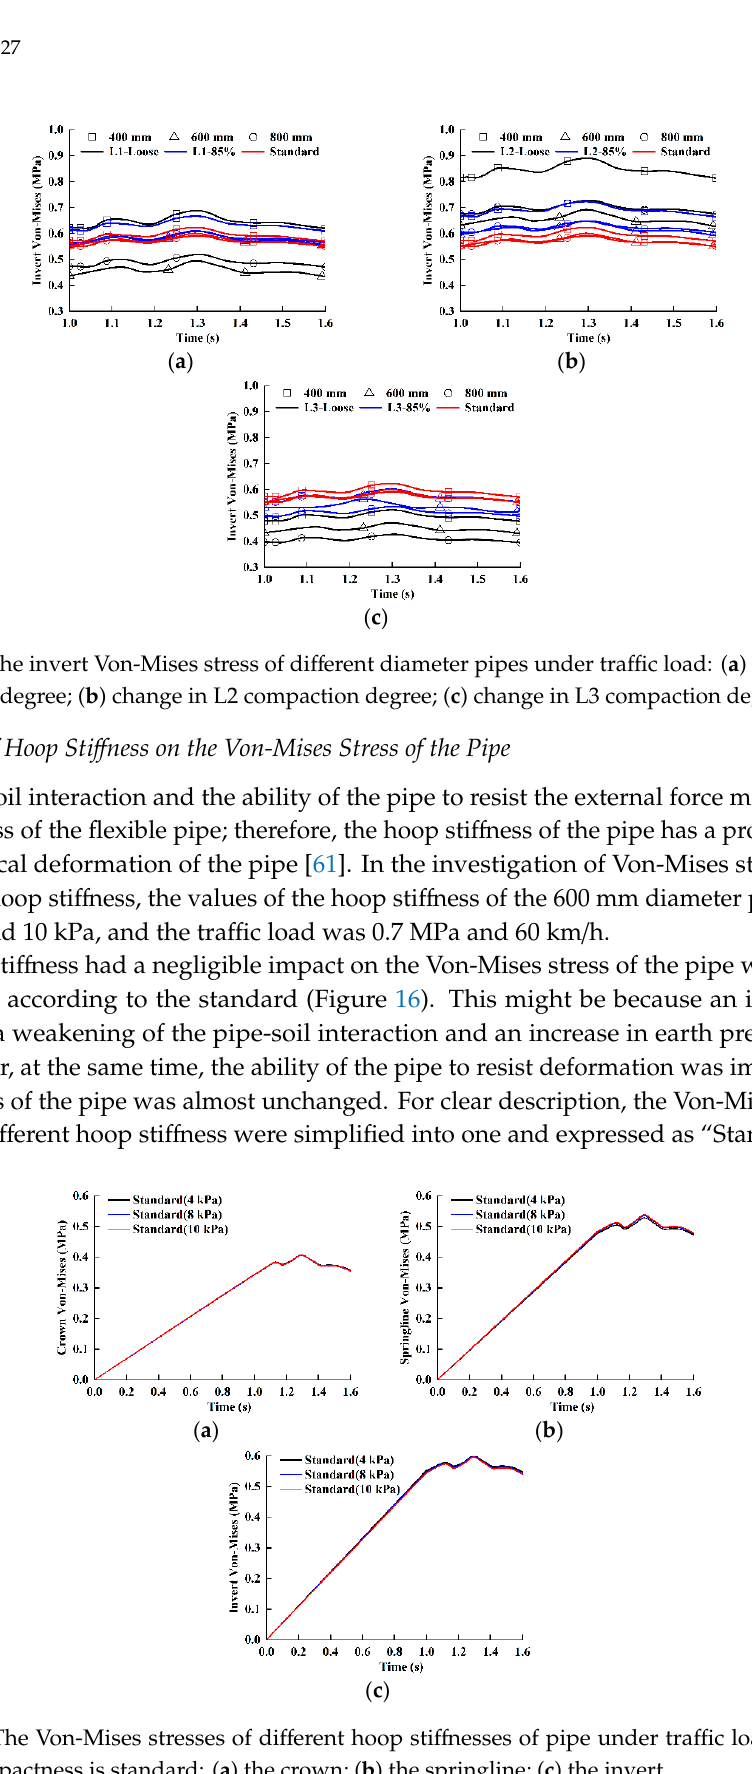
Figure 14. The springline Von-Mises stress of different diameter pipes under traffic load: ( a ) change in L1 compaction degree; ( b ) change in L2 compaction degree; ( c ) change in L3 compaction degree.